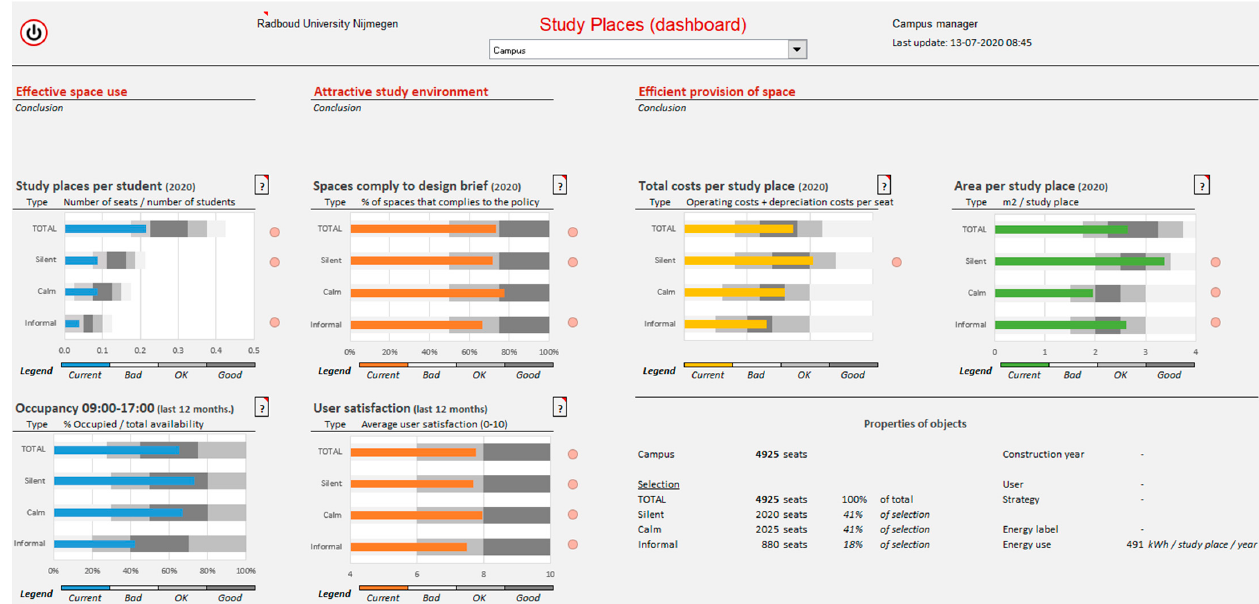
Figure 5. Main dashboard ‘Study places RU’ (tested in workshop 2).